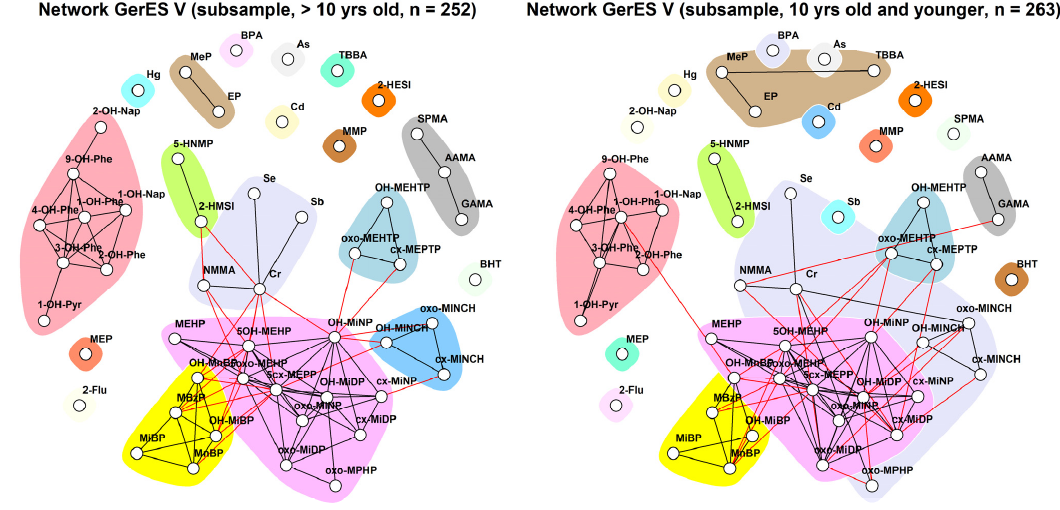
Figure 12. Stratification of the network for the GerES V subsample by median age (10 years old), using creatinine-standardised and creatinine-adjusted data. Data were corrected for sex, smoking status, ISCED, and BMI. Black lines indicate dependency between nodes (biomarkers) within a community; red lines indicate dependency between nodes in different communities.